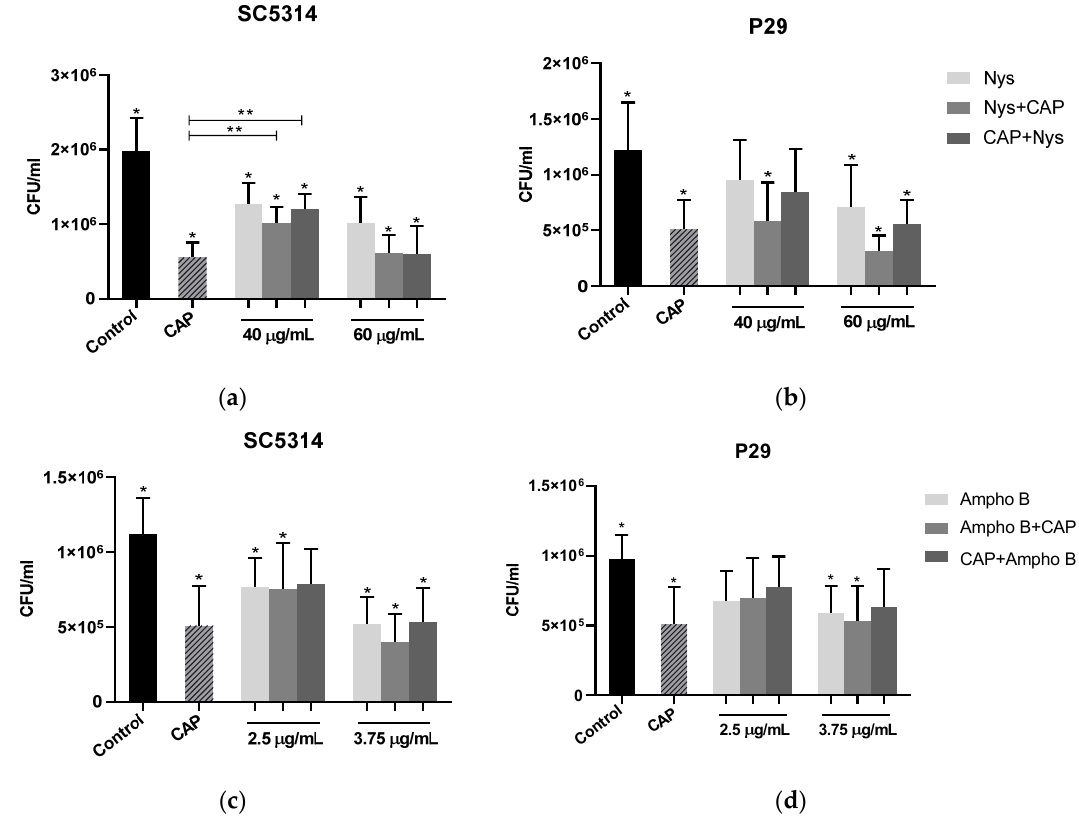
Figure 2. Values of CFU/mL of 24 h biofilms after associated treatments. ( a , b ) = isolated and associated treatments with Nystatin; ( c , d ) = isolated and associated with Amphotericin B. Control = no treatment; CAP = treatment with cold atmos- pheric plasma. Nys = treatment with nystatin; Ampho B = treatment with amphotericin B; Nys+CAP/Ampho B+CAP = previous treatment with nystatin or amphotericin B; CAP+Nys/CAP+Ampho B = previous treatment with CAP. (*) indicate significant differences ( p < 0.05) between the groups and the control. (**) indicate significant differences ( p < 0.05) between the isolated and associated treatments.